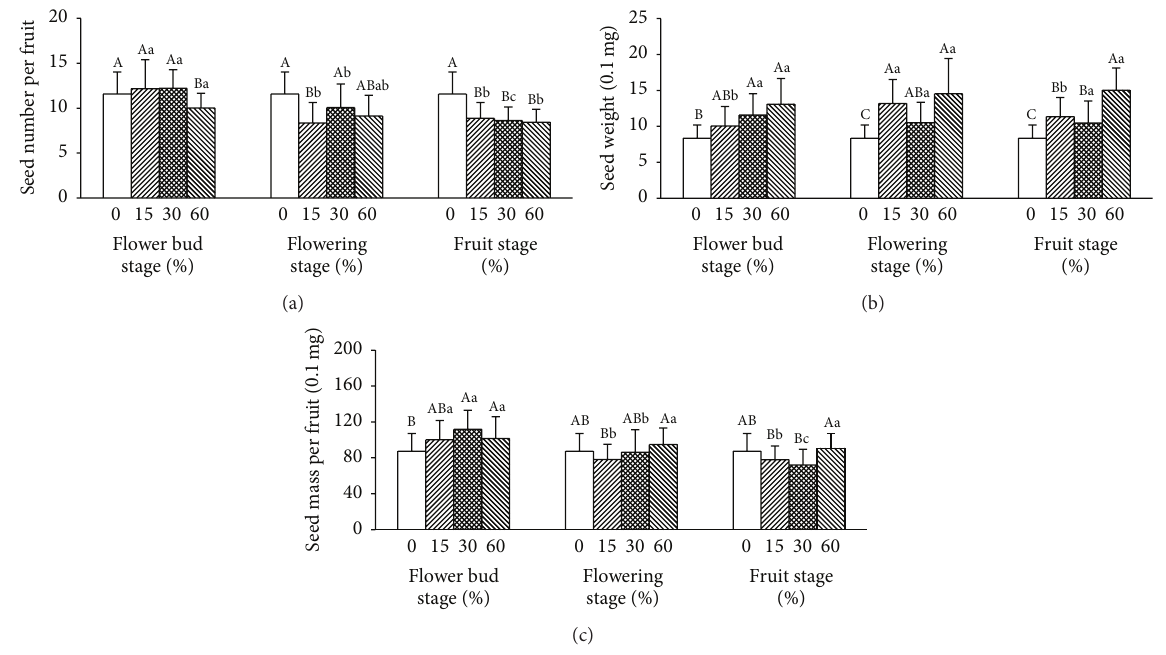
Figure 3: Effects of intensity of florivory (15%, 30%, 60%) at three reproductive stages on the seed number per fruit, the seed weight, and the seed mass per fruit. Data are means ± 1 SD. Uppercases above bars represent comparisons of the same reproductive stage at which florivory occurs. Lowercases represent comparisons of the same intensity of florivory. Bars with the same letters are not statistically different from each other (LSD test, 5%